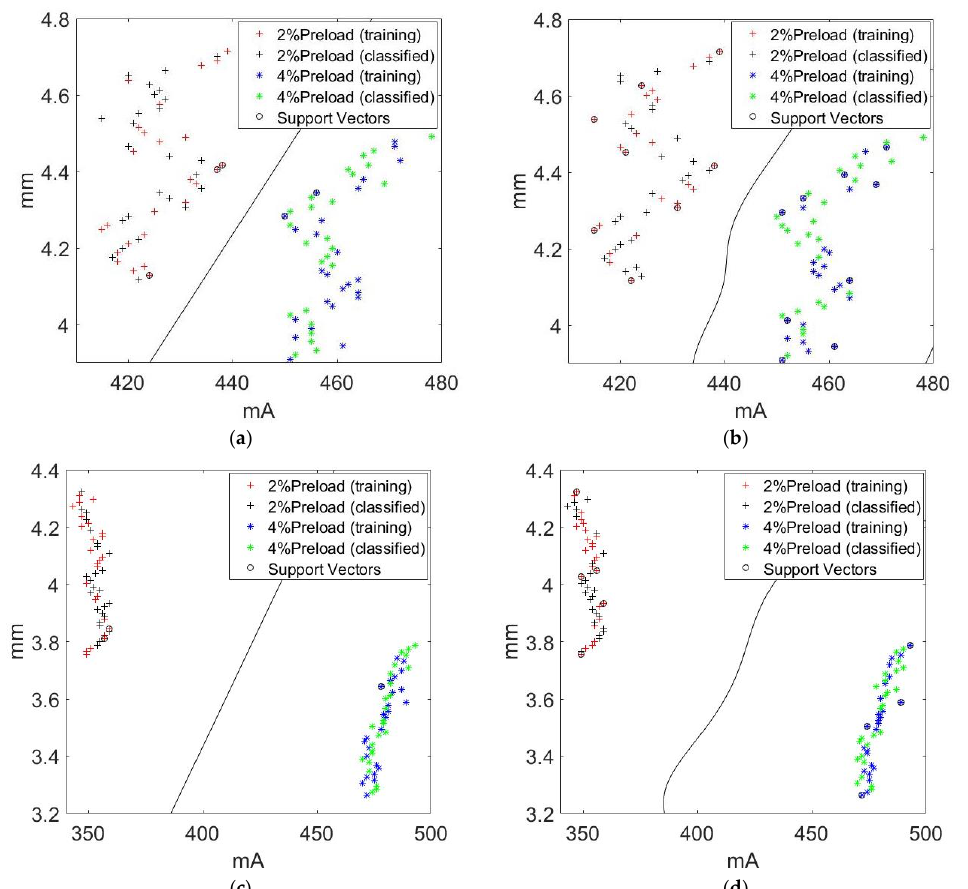
Figure 4. Thermal image [16] of the 4% ball-screw preload without pretension and payload under a repetitive motion speed of 900 rpm for 60 min. The temperature distribution of the ball nut for 60 min begins from the top left and ends to the bottom right.